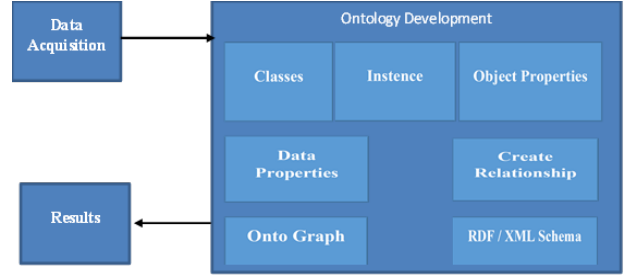
Fig. 3. Research Process for automation of software essence